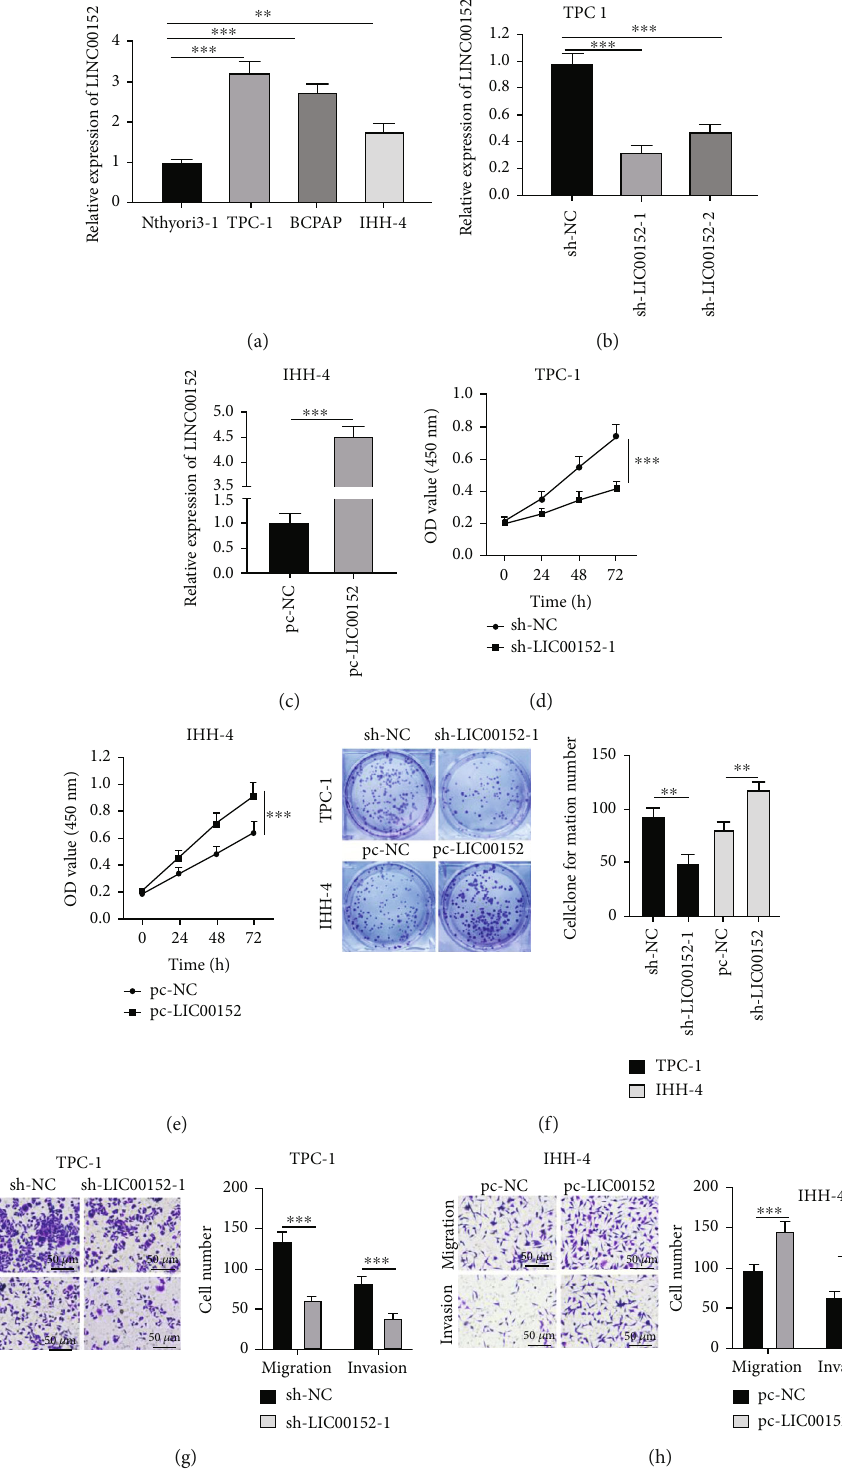
Figure 1: LINC00152 promotes PTC cell growth and invasion. (a) LINC00152 expression patterns in PTC cell lines measured by RT-qPCR. (b, c) Transfection e ffi ciency of LINC00152 in (b) TPC-1 and (c) IHH-4 cells veri fi ed by RT-qPCR. (d, e) Proliferation of (d) TPC-1 and (e) IHH-4 cells detected by CCK-8. (f) Proliferation of TPC-1 and IHH-4 cells detected by colony formation assay. (g, h) Migration and invasion of (g) TPC-1 and (h) IHH-4 cells assessed via Transwell assay. Repetitions = 3 . Data are expressed as mean ± standard deviation . The t -test was used for pairwise comparison. One-way ANOVA was used to determine statistical signi fi cance. Tukey ’ s multiple comparisons test was applied for post hoc test. ∗∗ p < 0 : 01 ; ∗∗∗ p < 0 : 001